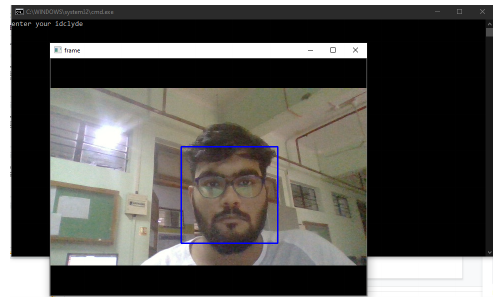
Figure 1. Primary database creation.